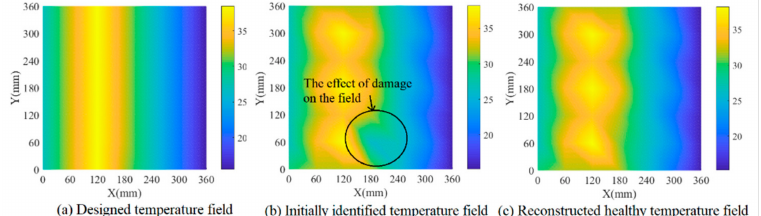
Figure 10. Temperature field identification results of simulation model